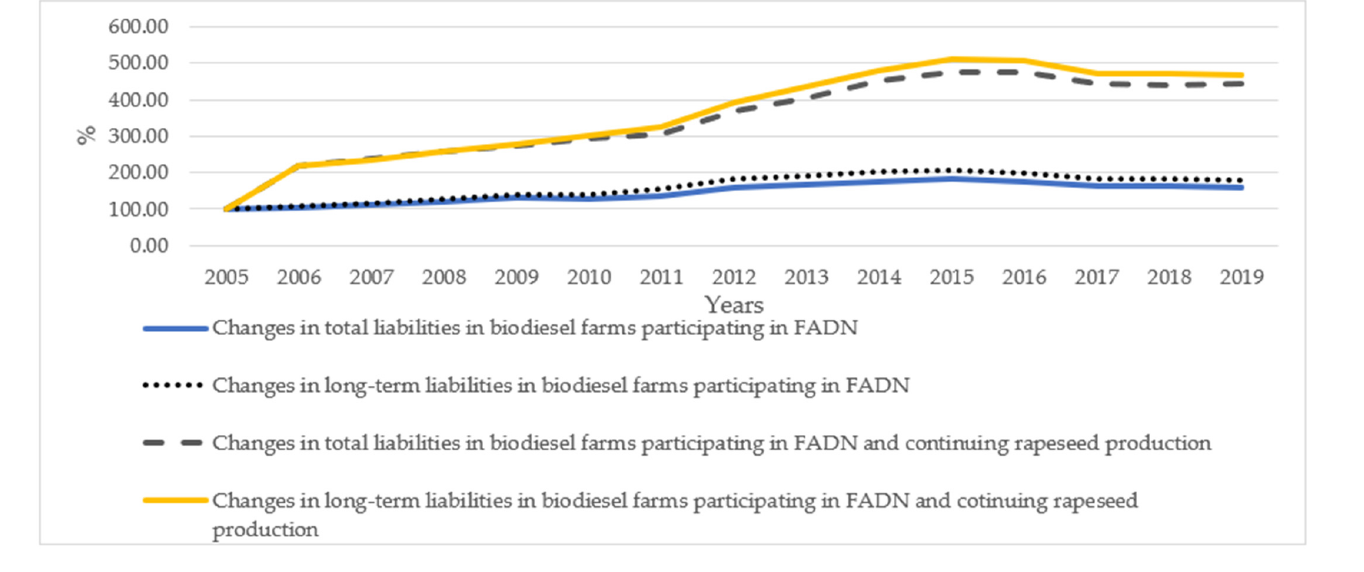
Figure 5. Changes in long-term liabilities in Polish biodiesel farms in 2005–2019 [%]. Source: own elaboration based on FADN data [52].